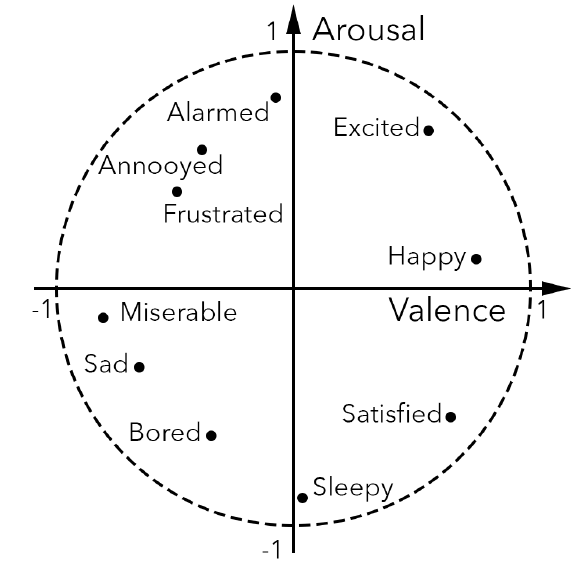
Figure 1. Valence-arousal